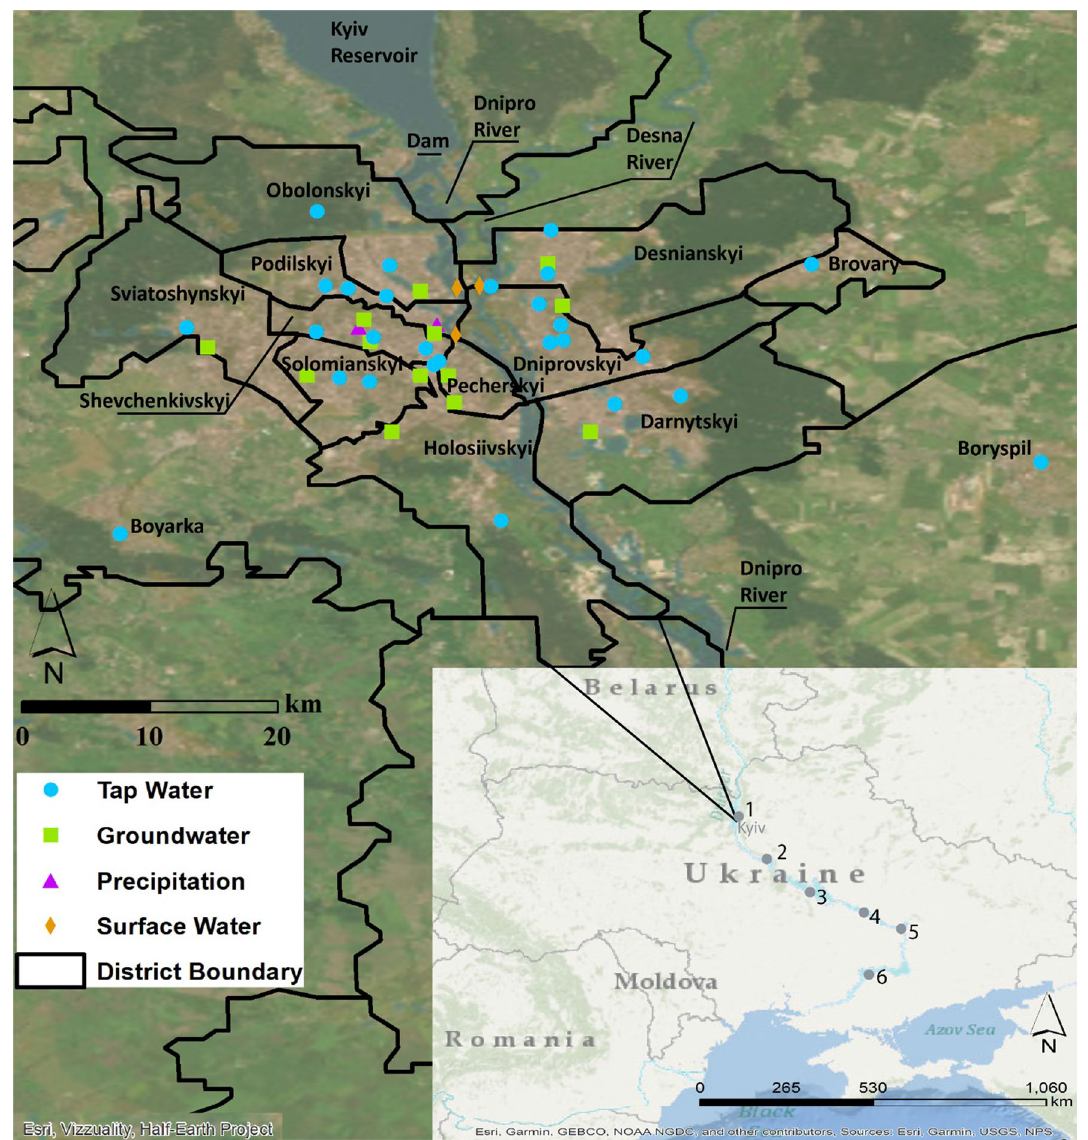
Fig. 1 Study location. Kaniv Reservoir and its dam (not pictured) are located approximately 50 km and 85 km south of Kyiv city, respectively (or within and 9 km south of Kyiv oblast, respectively). Tap water sampling locations are shown by blue circles, groundwater sampling loca- tions by green squares, precipitation collection locations by purple triangles, and river sampling locations by orange diamonds. On the inset map, reservoir locations along the Dnipro River are indicated by a gray circle and a number (1 = Kyiv, 2 = Kaniv, 3 = Kremenchutske, 4 = Kamianske, 5 = Dniprovske, and 6 = Kakhovske). Base maps from ESRI and district shapefile from R. Hijmans